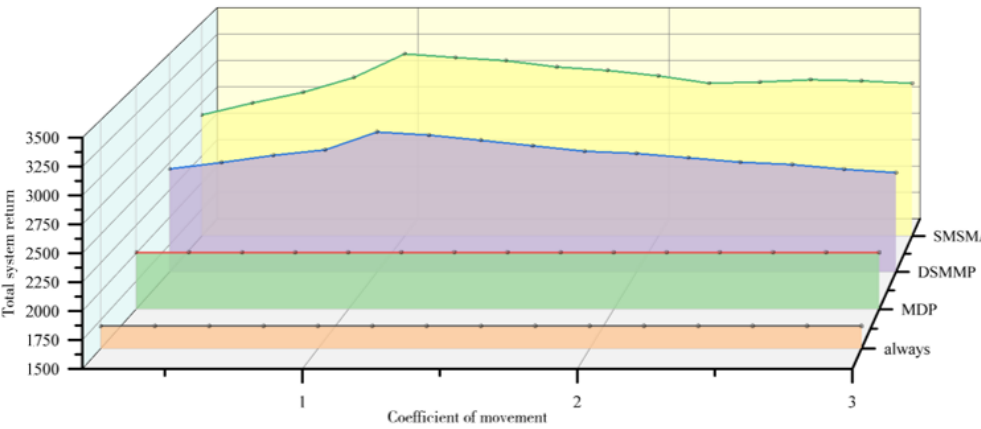
Figure 11. Effect of motion coefficient on total system return.